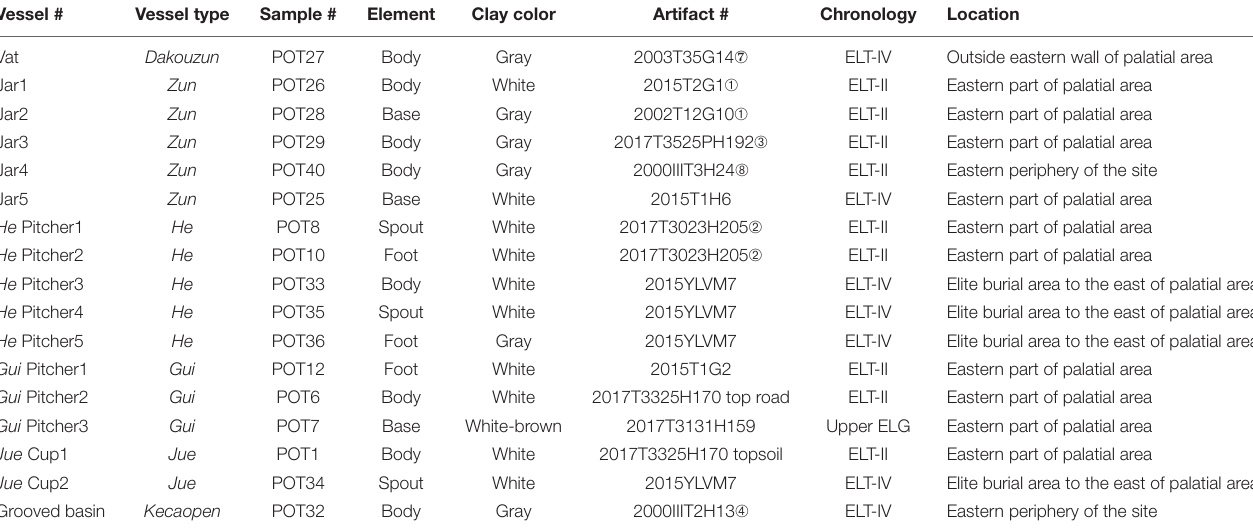
TABLE 1 | Ceramic samples